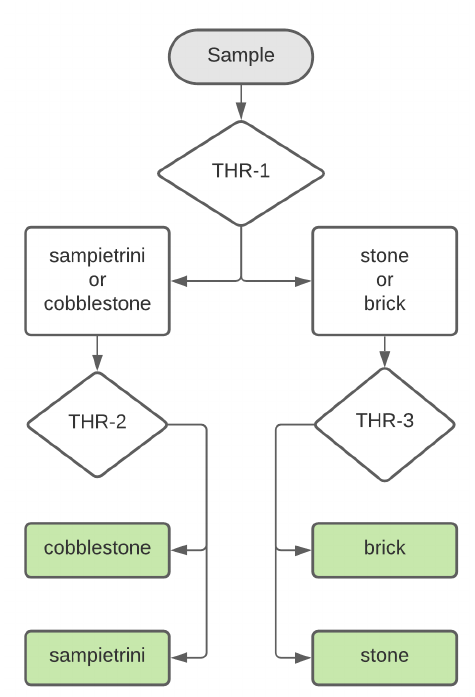
Figure 5. Workflow of the paving material characterisation